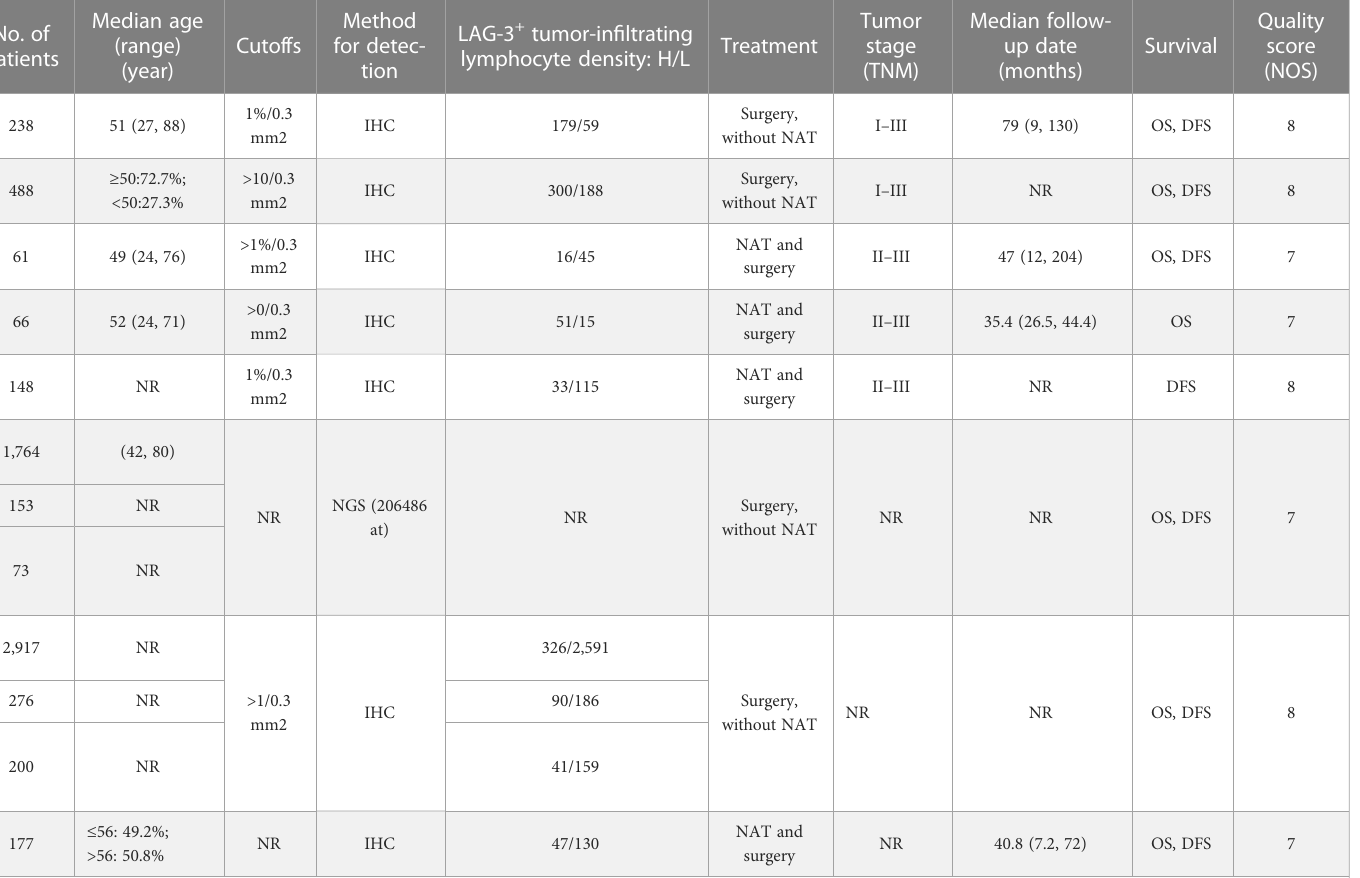
TABLE 1 Main characteristics of the included